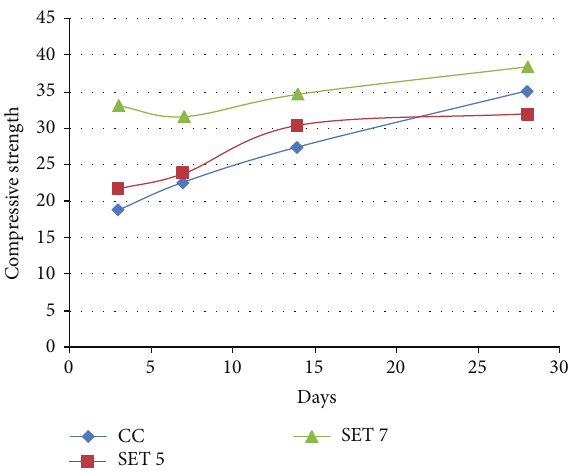
Figure 5: Comparison of control concrete with Set 5 and Set